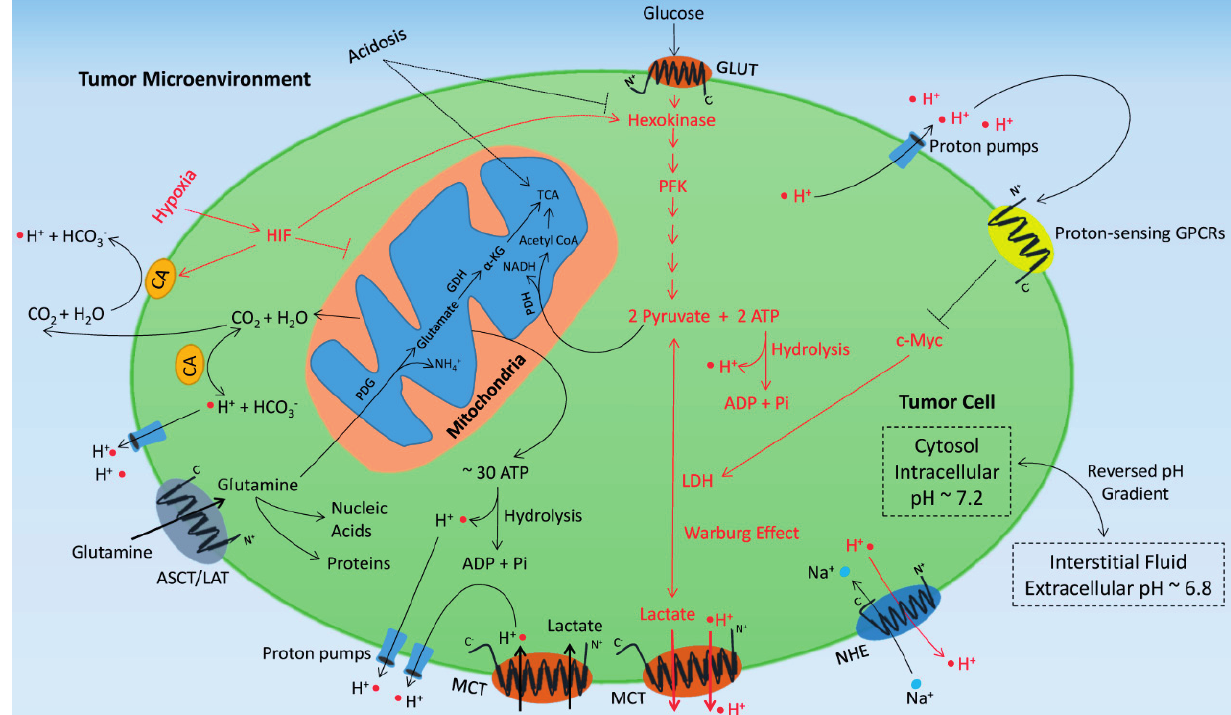
Figure 1. The complex interactions between cancer cell metabolism and the tumor microenvironment. Cancer cells exhibit increased glycolysis even in the presence of oxygen (Warburg effect) and under hypoxic conditions glycolysis may be further stimulated (shown in red). The stimulation of glycolysis increases proton production and facilitates proton efflux via an array of acid transporters such as MCT, NHE, and proton pumps, causing acidosis in the tumor microenvironment. Acidosis acts as a negative feedback signal by lessening glycolytic flux and facilitating mitochondrial respiration (shown in black). ASCT: Na + -dependent glutamine transporter; CA: carbonic anhydrase; GDH: glutamate dehydrogenase; GLUT: glucose transporter; GPCR: G-protein-coupled receptor; HIF: hypoxia inducible factor; LAT: Na + -independent glutamine transporter; LDH: lactate dehydrogenase; MCT: monocarboxylate transporter; NHE: sodium/hydrogen exchanger; PDG: phosphate-dependent glutaminase; PDH: pyruvate dehydrogenase; PFK: phosphofructokinase; TCA: tricarboxylic acid